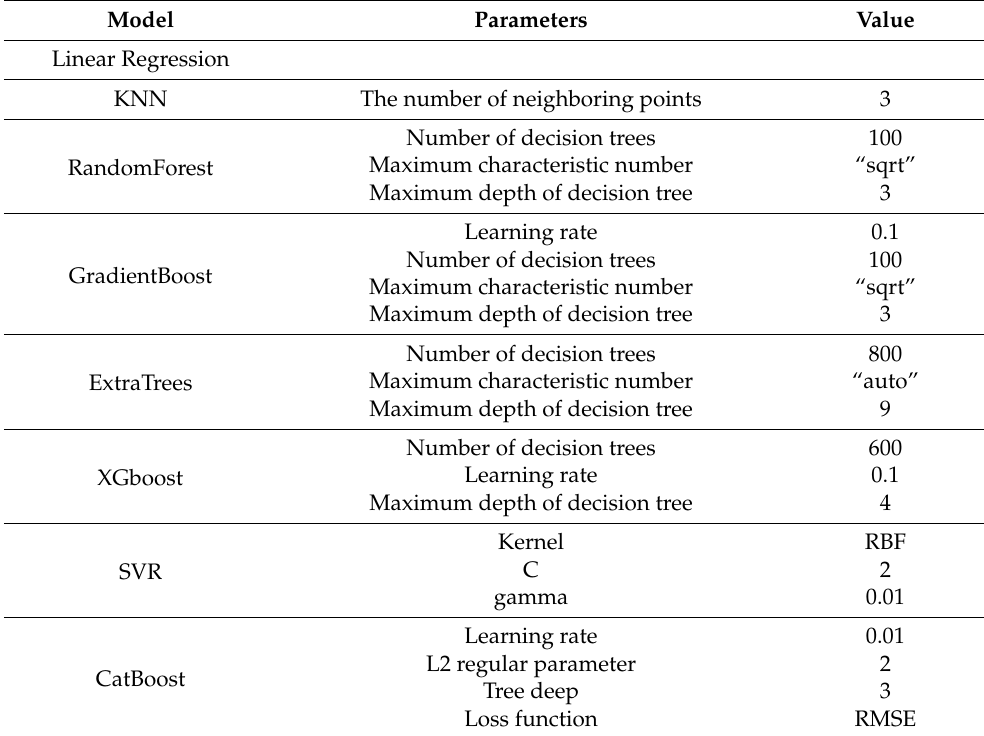
Table 8. Optimal parameters for each model.